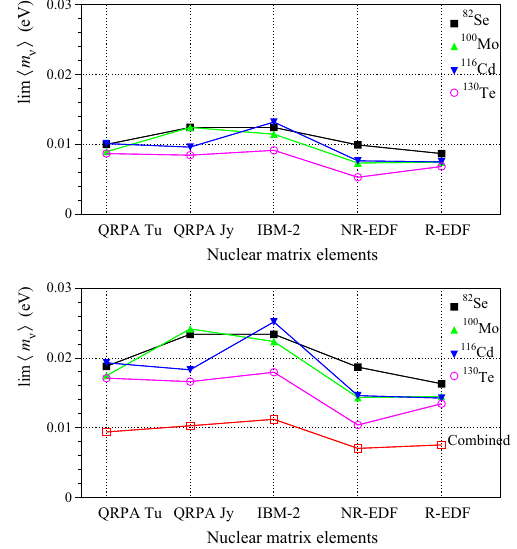
Fig. 6 Sensitivity to the neutrino mass of 0 ν 2 β experiments with (upper figure) and CUPID-4 (lower figure) options, assuming a level of background of 4 × 10 − 6 counts/yr/keV/kg. The values of lim (cid:2) m ν (cid:3) were estimated by using the phase space factors from Ref. [47], the value of the axial vector coupling constant g A = 1 . 27, and the NME calculated in the framework of different nuclear models: QRPA Tu [50]; QRPA Jy [51]; IBM-2 [46]; NR-EDF [52]; and R-EDF